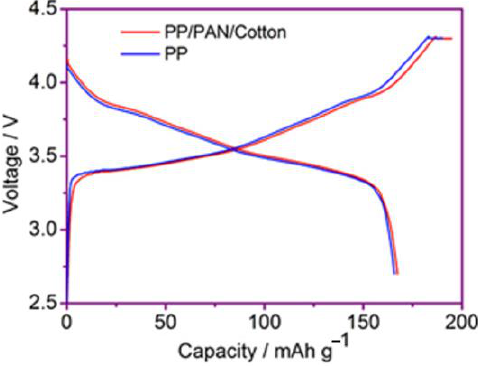
Figure 9. Initial charge – discharge curves of the cell using PP membrane and modified PP/PAN/cot- ton fibers composite membrane.